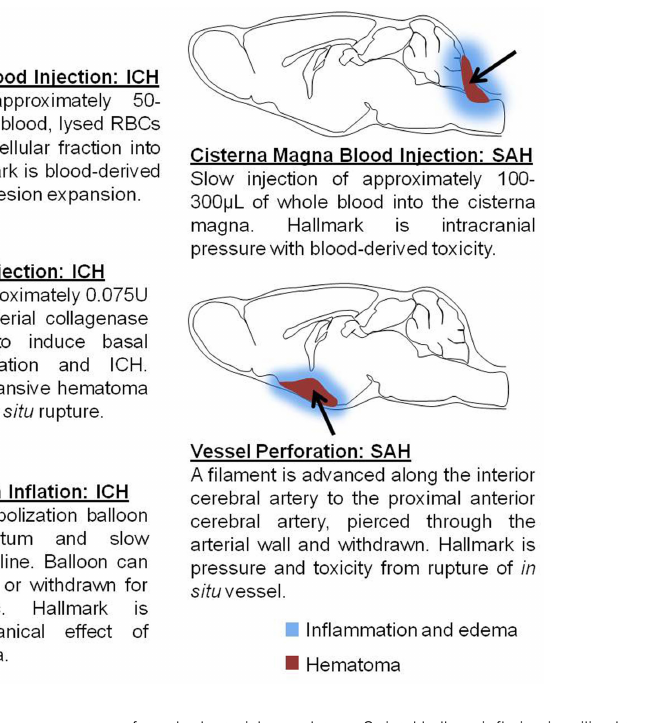
FIGURE 1 | Schematic depicts models commonly used to mimic intracerebral hemorrhage (ICH) and subarachnoid hemorrhage (SAH). Autologous blood injection involves single- or double injection of autologous blood, or blood fractions, to generate a hematoma within the brain parenchyma. Collagenase injection is accomplished through the injection of recombinant bacterial collagenase to mimic blood extravasation following the